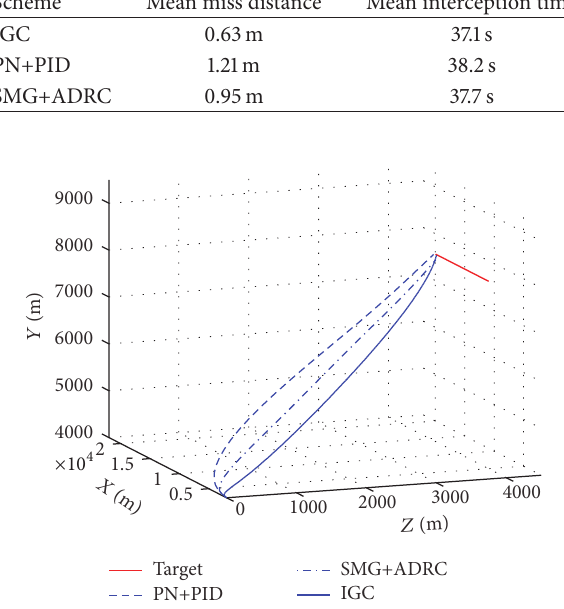
Figure 3: The interceptor-target relative motion in Scenario 1.